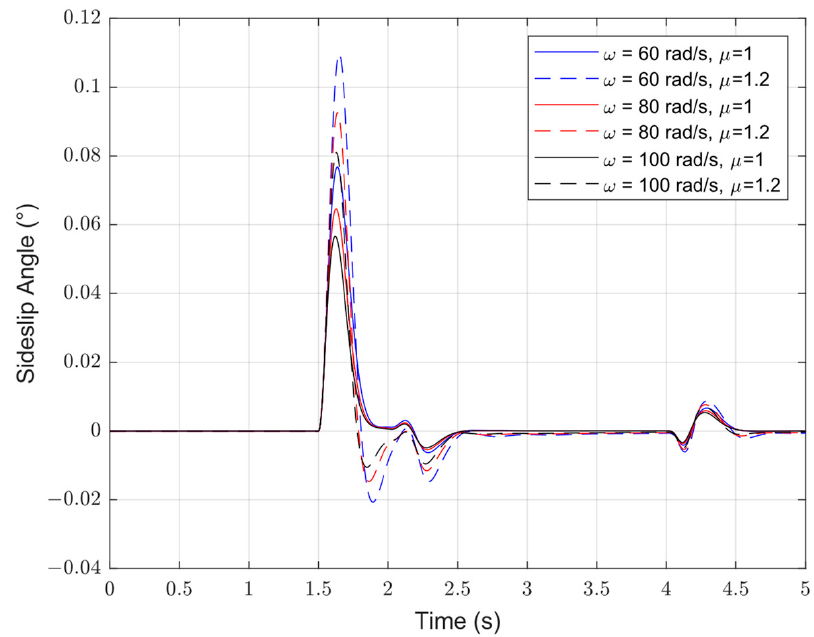
Figure 13. Response of Sideslip Angle with External